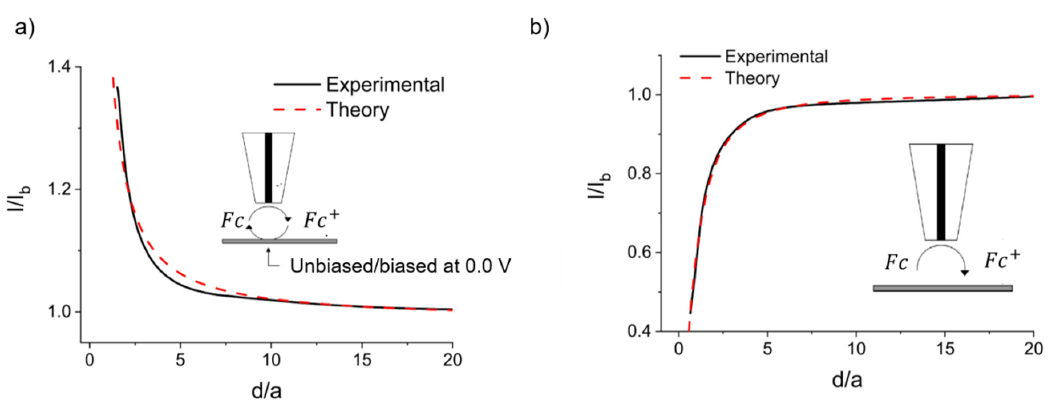
Figure 3. Approach curves recorded using Fc as redox mediator with a Pt microdisk 12.5 µm radius, above the bare gold surface ( a ) and the surrounding PTFE insulator ( b ). Red dashed lines refer to theoretical diffusion-controlled processes. The tip was biased at 0.4 V and the substrate was either unbiased or biased at 0.0 V.